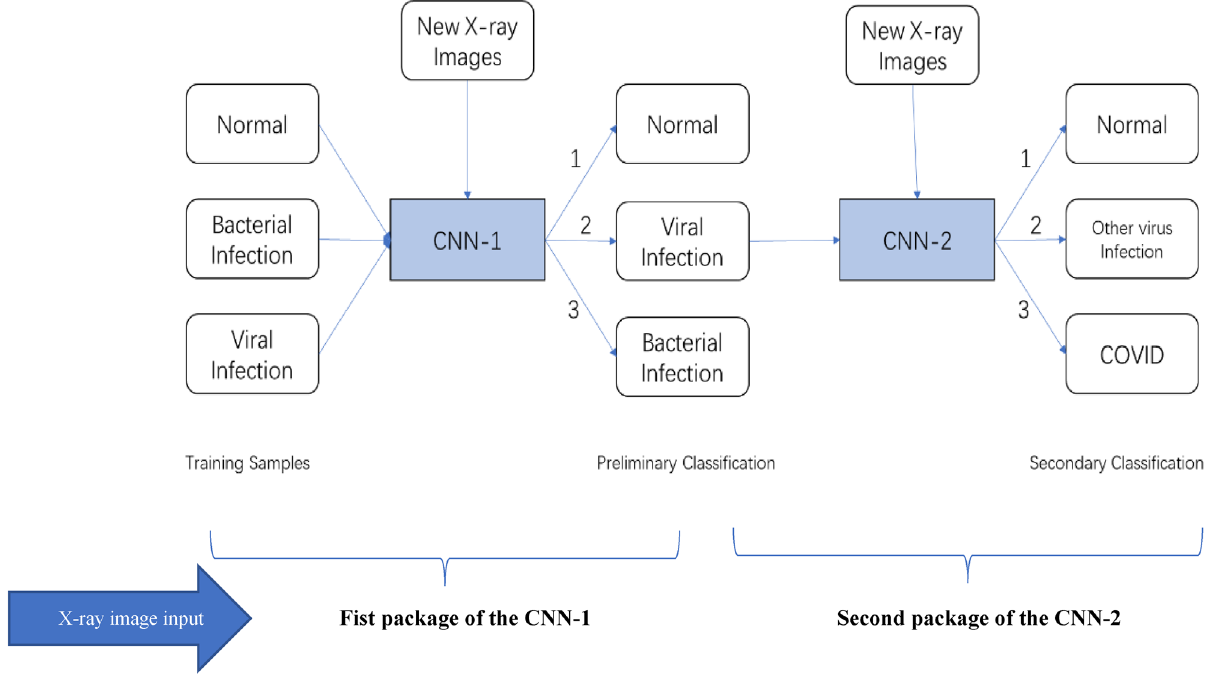
Figure 2. The execution framework of the proposed